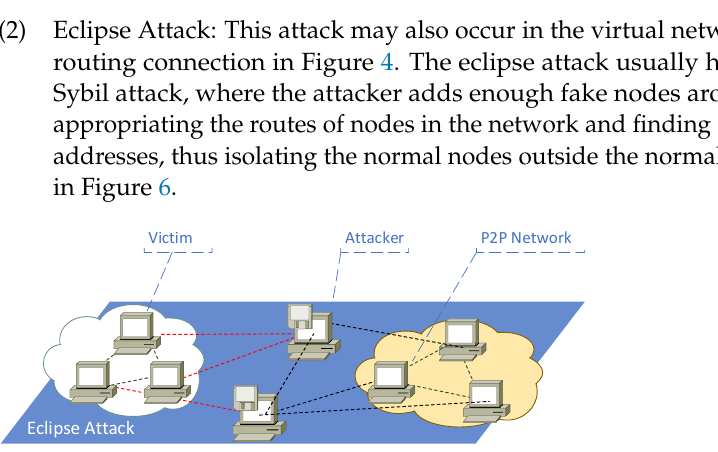
Figure 6. Eclipse attack